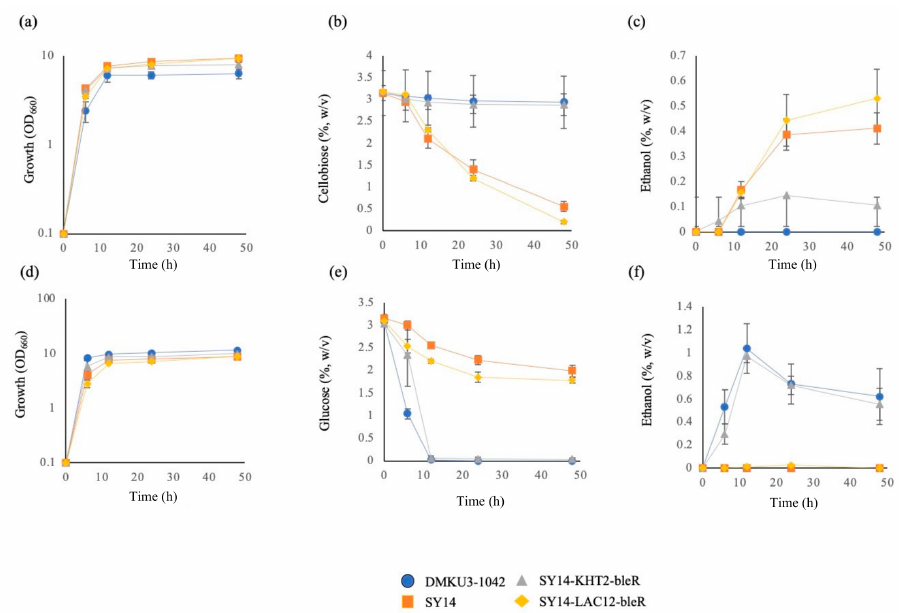
Figure 5. Cellobiose and glucose fermentation abilities of SY14 and SY14 derivatives into which KHT2 - bleR or LAC12 - bleR was introduced. SY14, SY14-KHT2-bleR, SY14-LAC12-bleR and the parental strain were grown in 30 mL of YAYC ( a – c ) or YAYD ( d – f ) medium at 40 ◦ C under a shaking condition at 160 rpm. ( a , d ) Cell growth was determined by measuring cell density at OD 660 . Concentrations of cellobiose ( b ), glucose ( e ) and ethanol ( c , f ) in the culture medium were determined by HPLC as described in Materials and Methods. Error bars indicate standard deviation of three independent